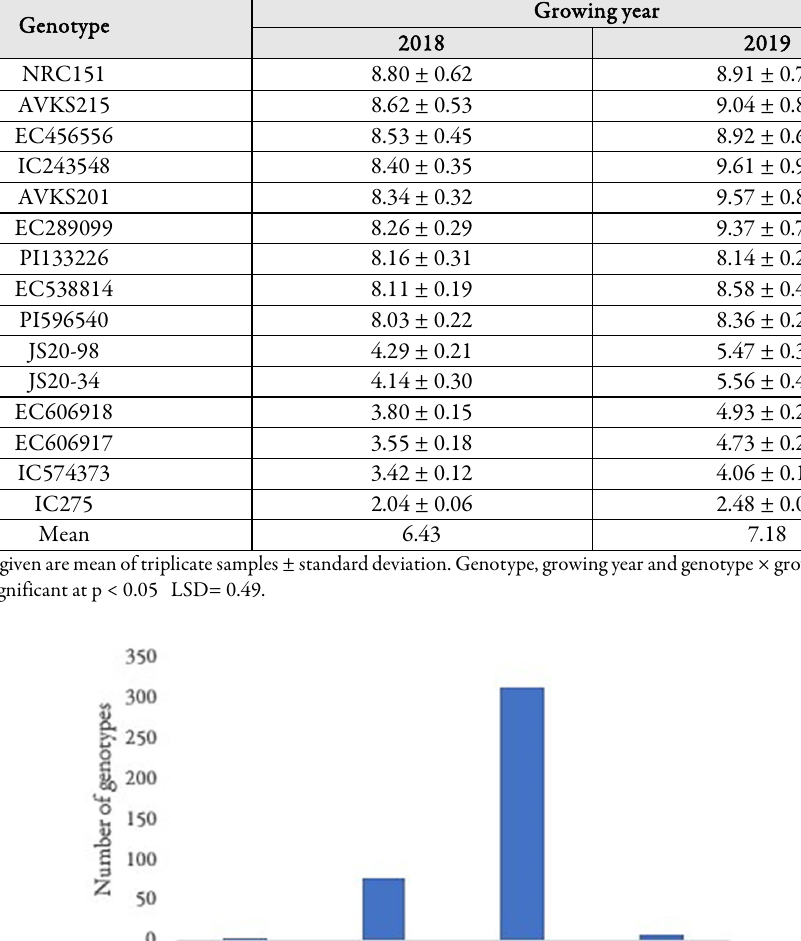
Table 1. Phosphatidylcholine content (mg/g soy flour) in high and low phosphatidylcholine containing soybean genotypes across growing years